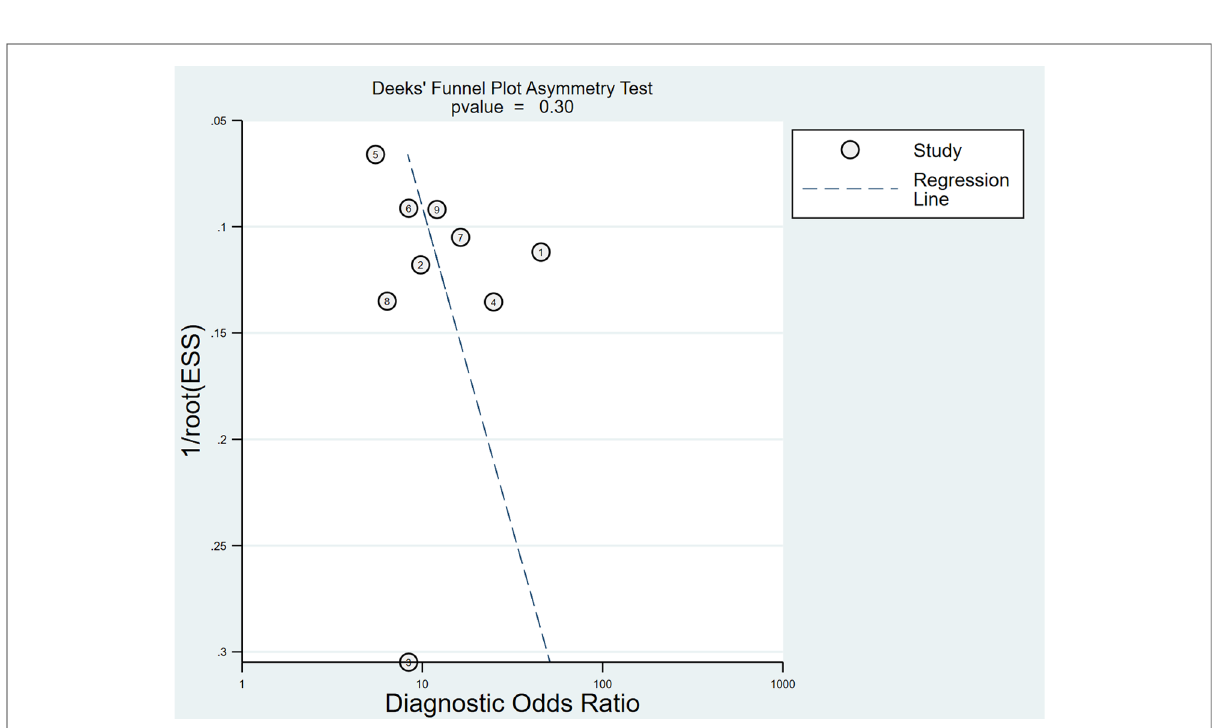
Figure 12 Funnel plot of myelography for the diagnosis of